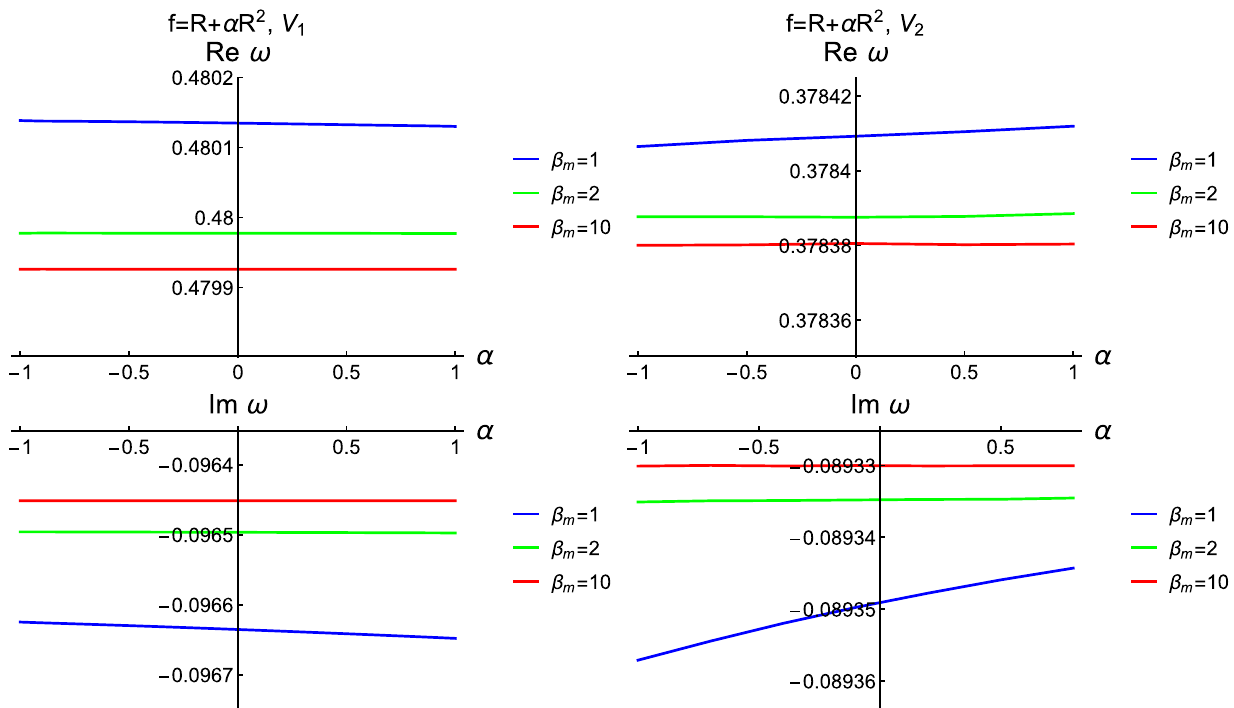
Fig. 3 The real part (upper) and imaginary part (lower) of the funda- mental QNM frequencies of the Born-Infeld black holes in the Palatini R + α R 2 gravity are exhibited. The frequencies are shown with respect